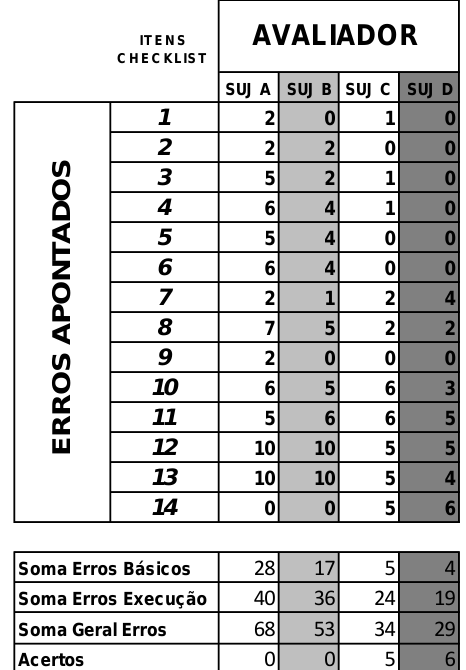
Tabela 6. Somatória dos erros cometidos por cada participante a partir da análise de vídeo e utilização do